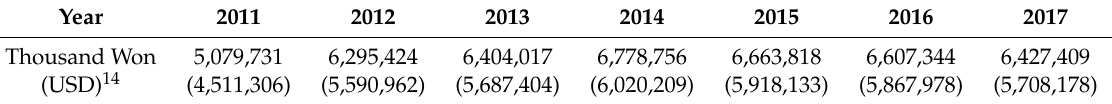
Table 5. Total Budget of Education Committee 2011~2017 (included Sangha Education Fund).